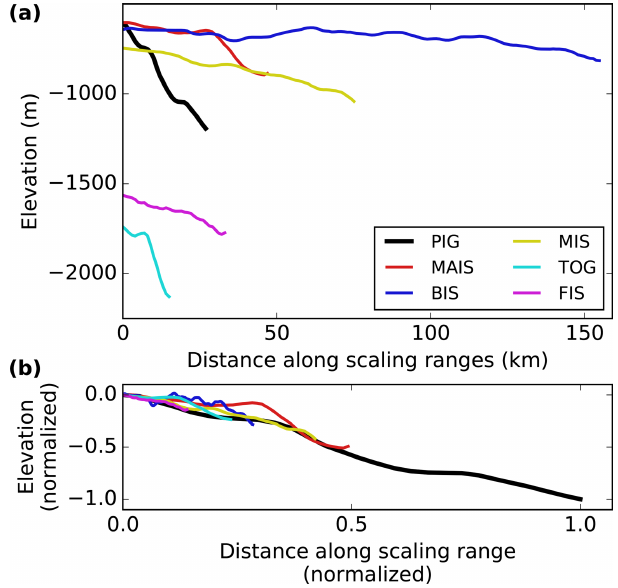
Figure A2. Same as Fig. 3, but here for the five discarded Antarctic